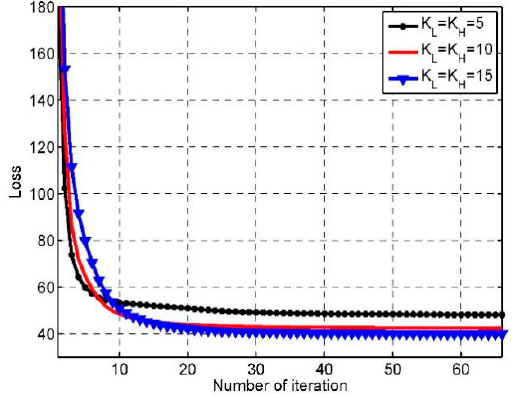
Figure 8. The convergence of the proposed algorithm.